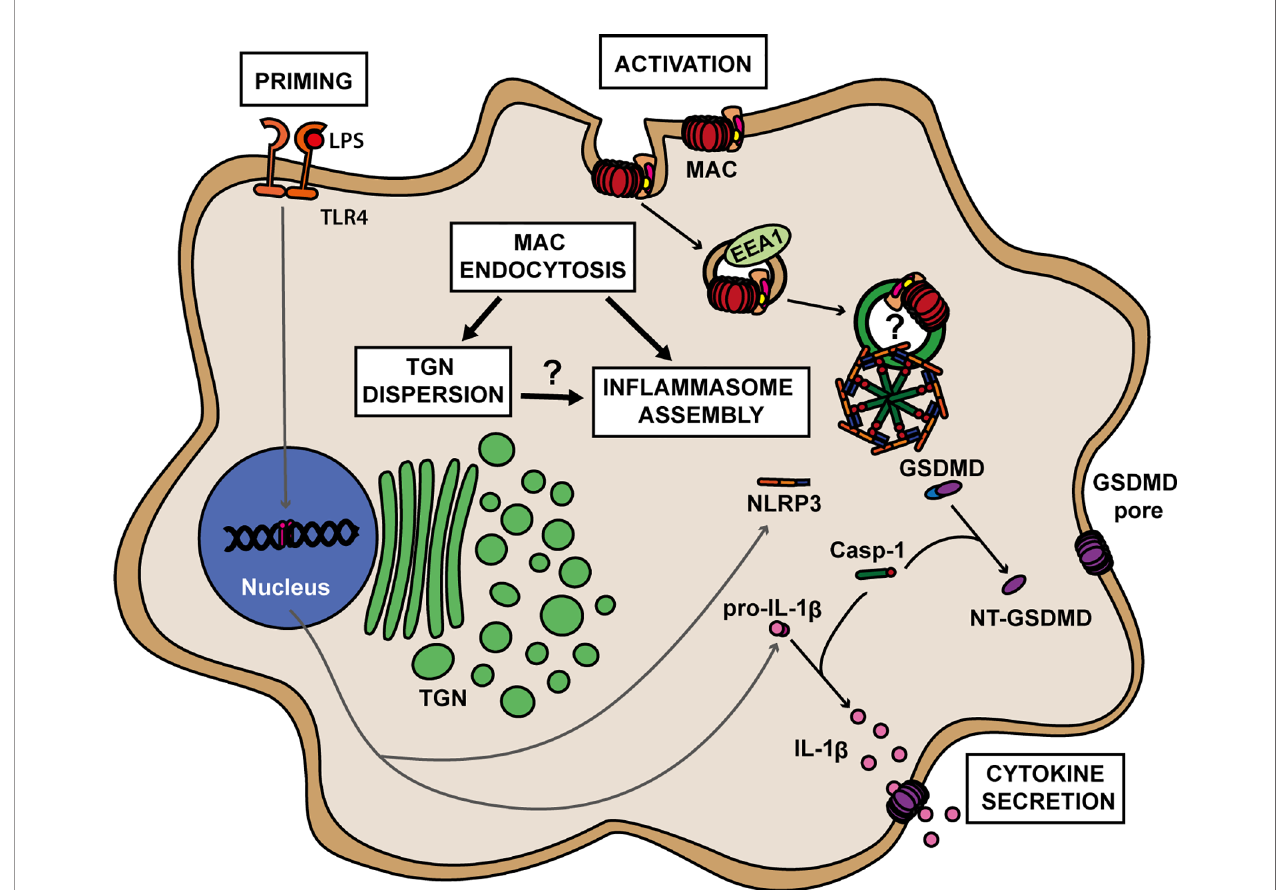
FIGURE 6 | A proposed model for MAC-mediated NLRP3 in fl ammasome activation in human macrophages. Formation of the MAC in the cell membrane triggers its internalization via EEA1+ endosomes. Endocytosis of the MAC leads to dispersion of the trans-Golgi network (TGN) and to the assembly of the NLRP3 in fl ammasome. The roles of TGN dispersion as well as any direct involvement of MAC components on in fl ammasome assembly remain to be elucidated. Within the NLRP3 complex, caspase 1 (Casp-1) becomes active and cleaves GSDMD into its pore-forming subunit, NT-GSDMD, and pro-IL-1 b into its active form IL-1 b . Multiple NT-GSDMD subunits assemble in the cell membrane to form GSDMD pores resulting in the release of IL-1 b to the extracellular